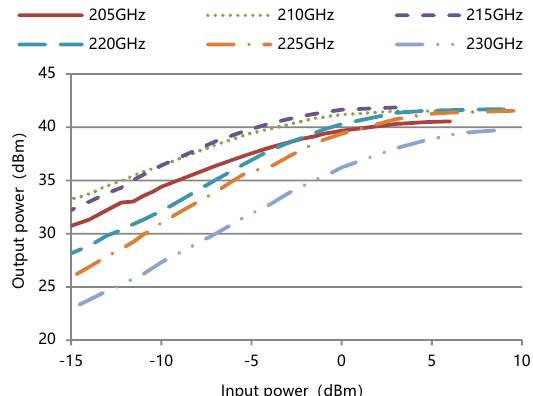
Figure 16. Measured output power against input power for the TWT at different frequencies .